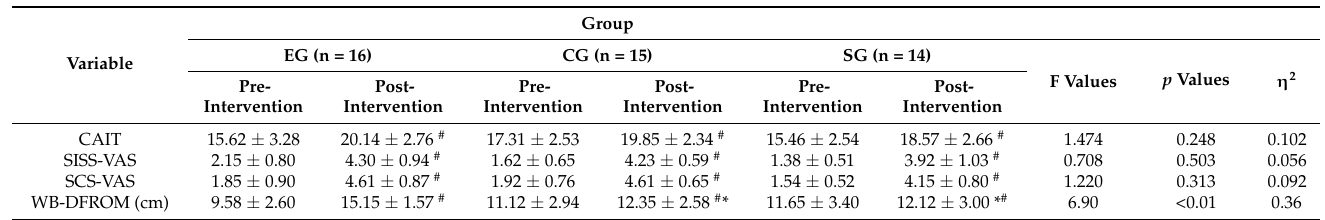
Table 3. CAIT, SIS-VAS, SCS-VAS, and WB-DFROM before and after the intervention. Data are reported as mean ± SD.